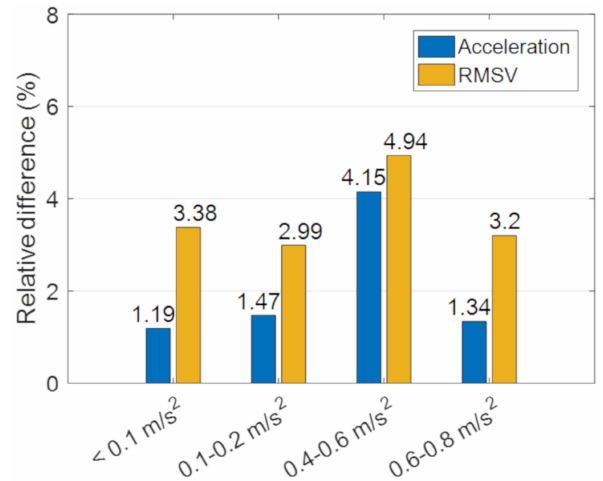
Figure 18. Relative di ff erences of acceleration and RMS velocity in the 1 / 3 octave band between the MEMS and PCB